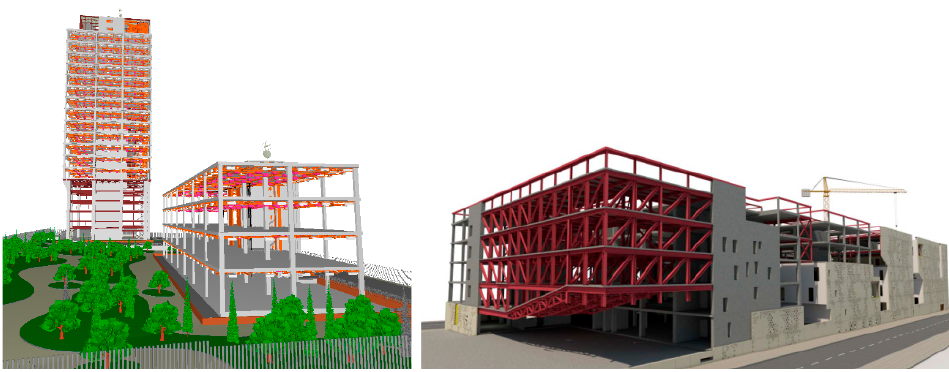
Figure 3. BIM model of Torre Isla Chamartín ( left ) and BIM model City of Justice of Cordoba ( right ), developed by BIM Modeling Team, Total BIM Consulting.